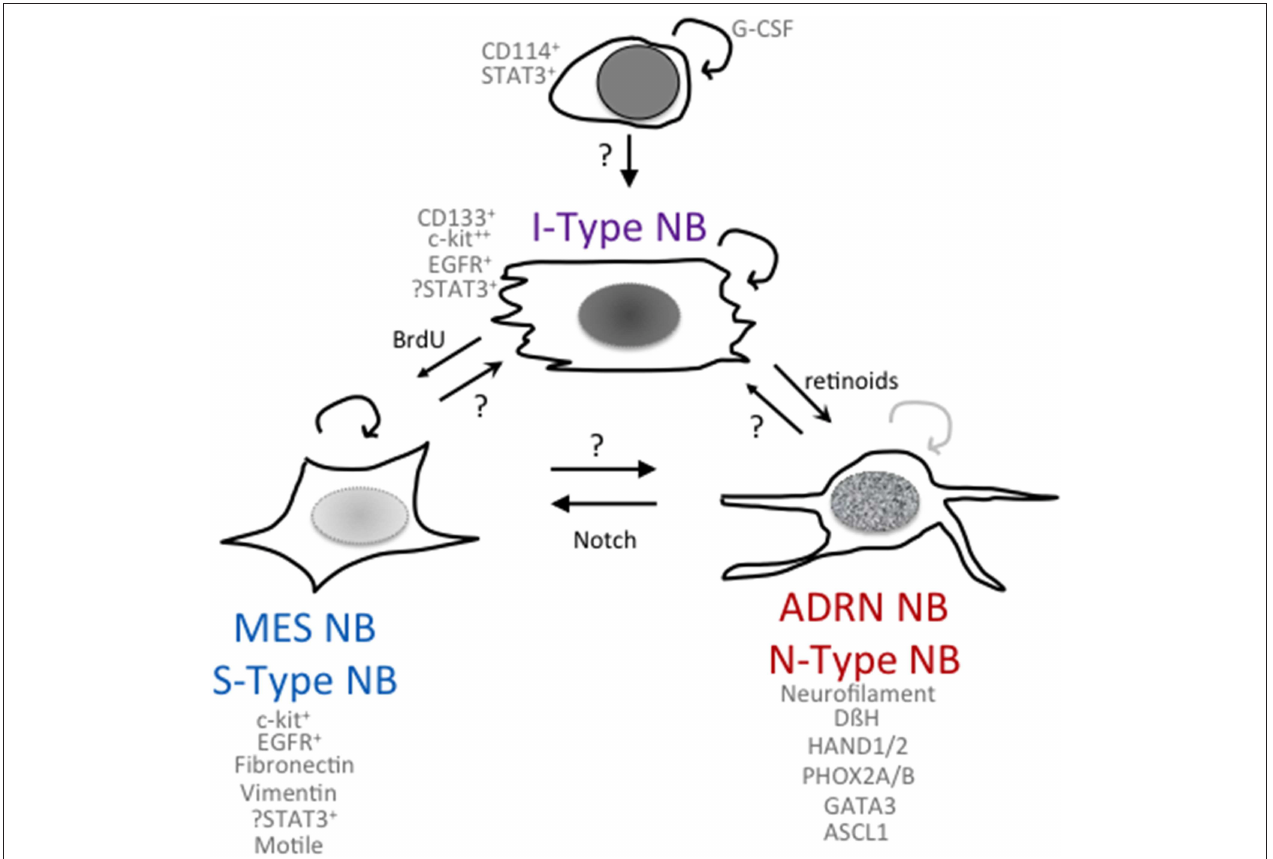
FIGURE 1 | Phenomes of NB cells with cancer stem cell or tumor-initiating properties. Schematic of potential relationships among NB cells with differing phenotypes and